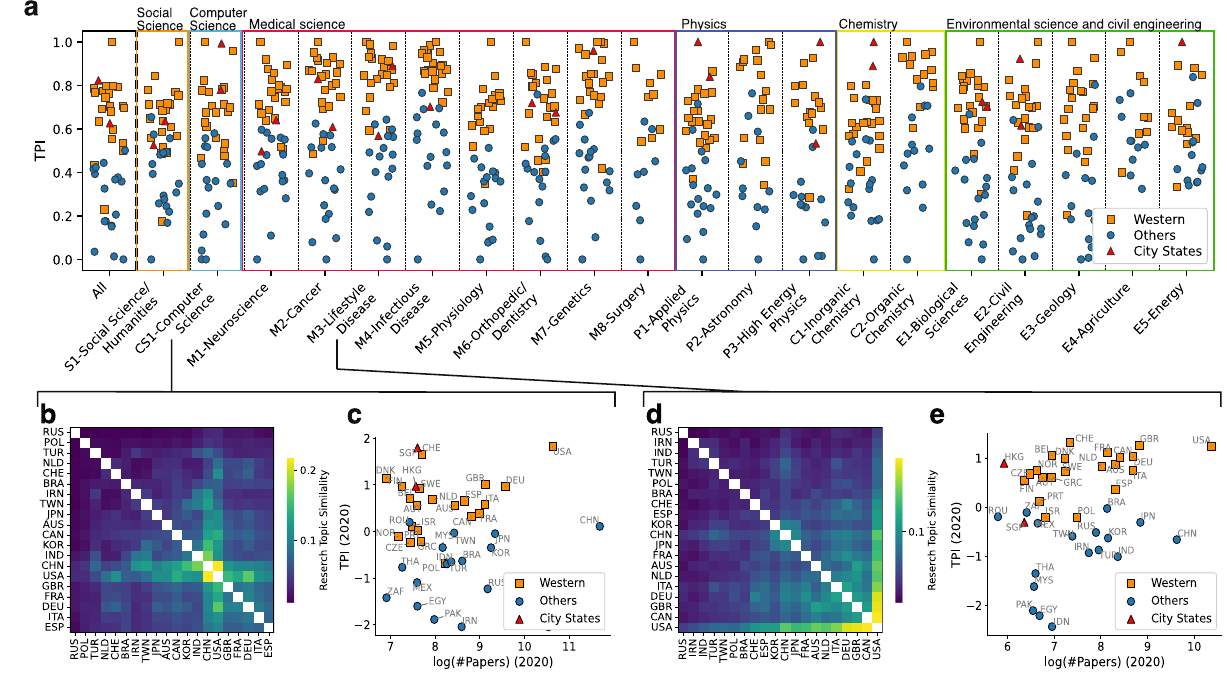
Figure 3. Detailed analysis topic progress in each domain. ( a Strip )plot of TPI (normalized 0 to 1) of nations in 2020 (in 2019 for M4-Infectious Diseases) in whole domains and in each of the 20 domains. Nations that published less than 300 papers during the year in each domain are excluded. ( b ) Cosine similarity of T between the top 20 nations in the number of papers in 2020 sorted by average linkage clustering in CS1-Computer Science. ( c ) Detailed plot of domains: the number of papers and TPI for each nation in CS1-Computer Science. ( d , e ) Same plots of ( b , c ) for M3-Lifestyle Disease. The figures were generated using matplotlib(3.6.0) and labeled with